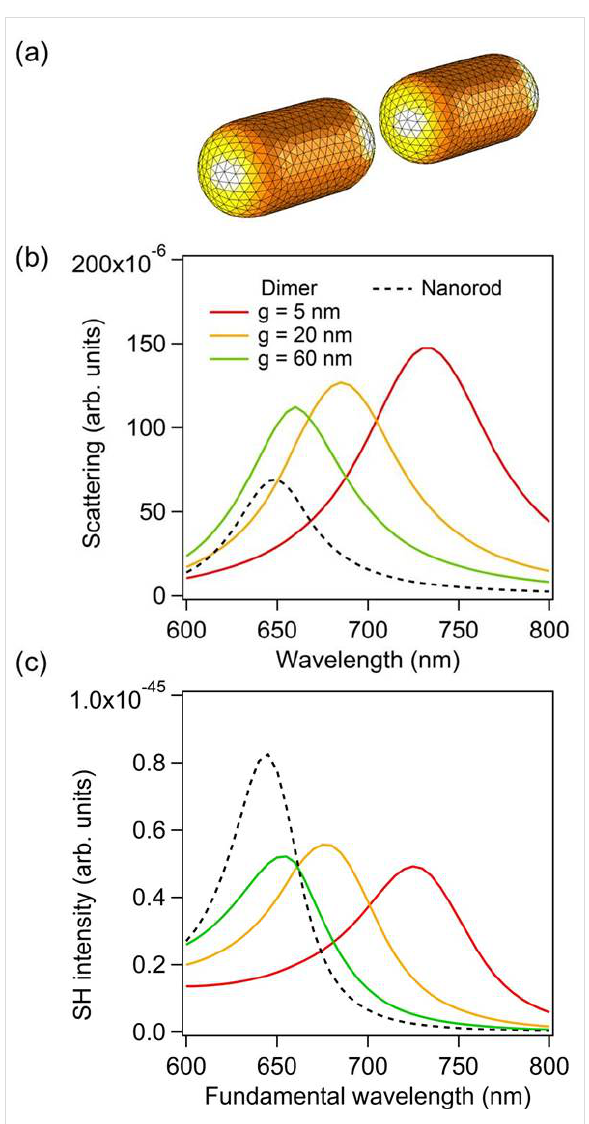
Figure 1: (a) Example of one mesh used for the simulations. The nanorod overall length and diameter are 85 nm and 40 nm, respective- ly. In the present case, the gap g is 20 nm. (b) Scattering intensity as a function of the wavelength for nanodimers with gaps g = 5 nm, 20 nm, and 60 nm as well as for a single nanorod. (c) Second harmonic inten- sity as a function of the wavelength for nanodimers with gaps g = 5 nm, 20 nm, and 60 nm as well as for a single